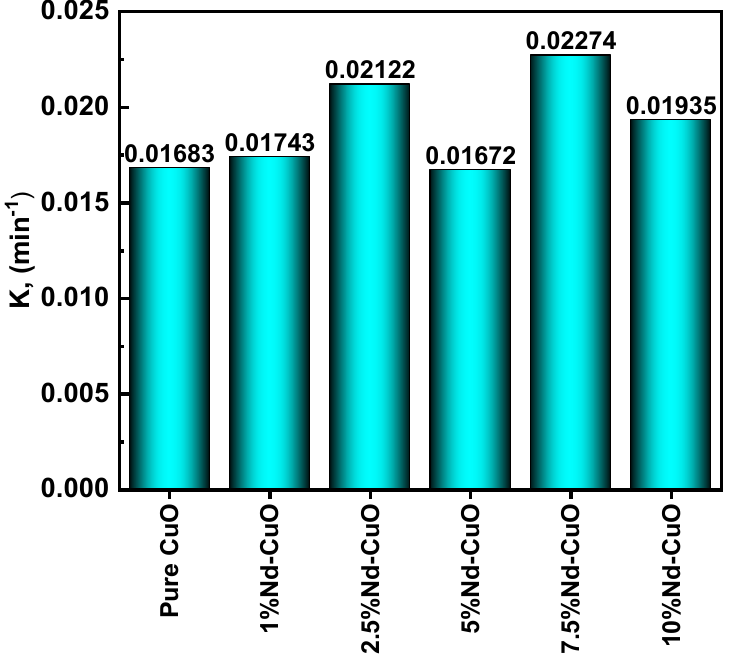
Figure 5. Absorption spectra of MB dye under visible light irradiation with pure CuO and five dif- ferent concentrations of nanostructured Nd-doping CuO.